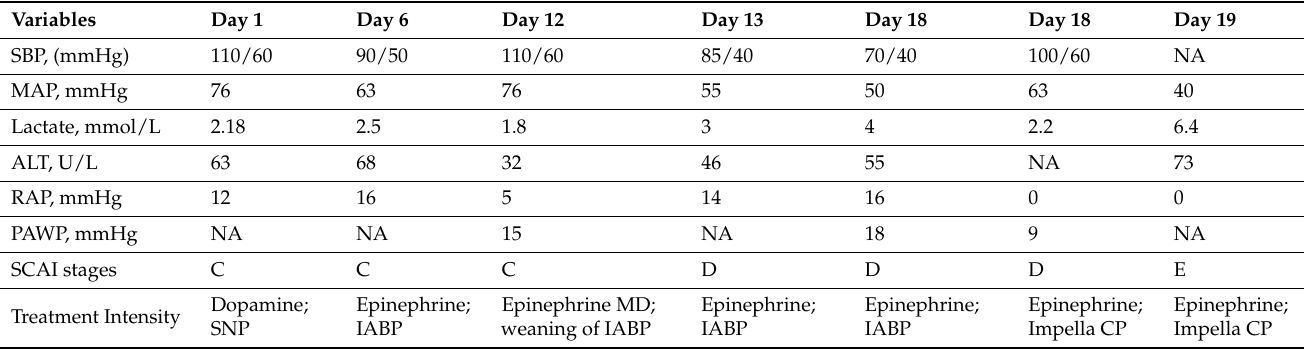
Table 1. Clinical variables and parameters to define society for cardiovascular angiography and inter- ventions Stages [6]. SBP= systolic blood pressure; MBP= mean blood pressure; ALT = alanine amino- transferase; RAP = right atrial pressure; PAWP = pulmonary arterial wedge pressure; SCAI = Society for Cardiac Angiography and Interventions; SNP = sodium nitroprusside; NA = not